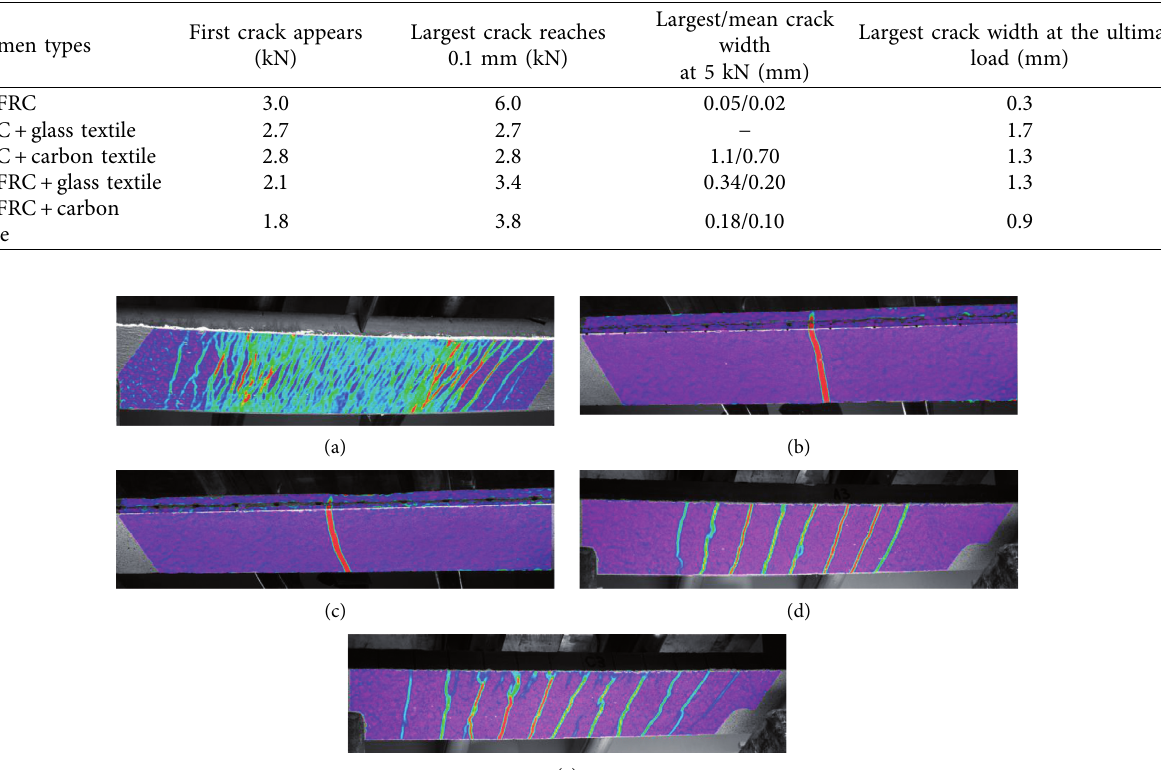
Figure 3: Crack pattern of the specimens at 0.1 mm crack opening. (a) UHPFRC, (b) UHPC +glass textile, (c) UHPC +carbon textile, (d) UHPFRC+glass textile, and (e) UHPFRC+ carbon